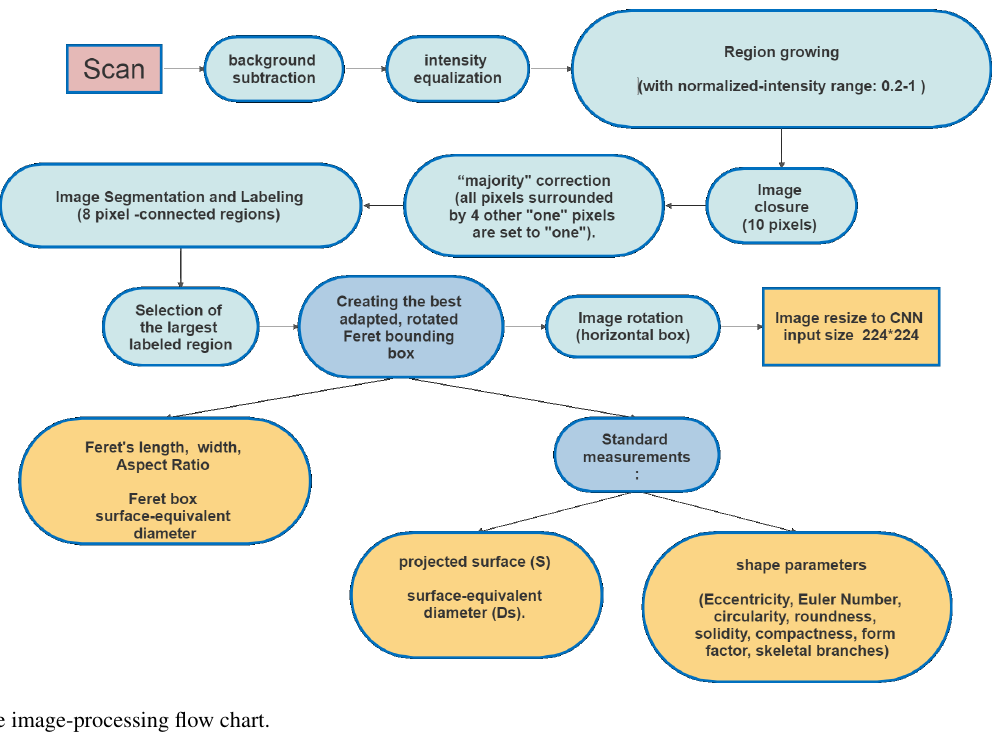
Figure 11. The image-processing flow chart.